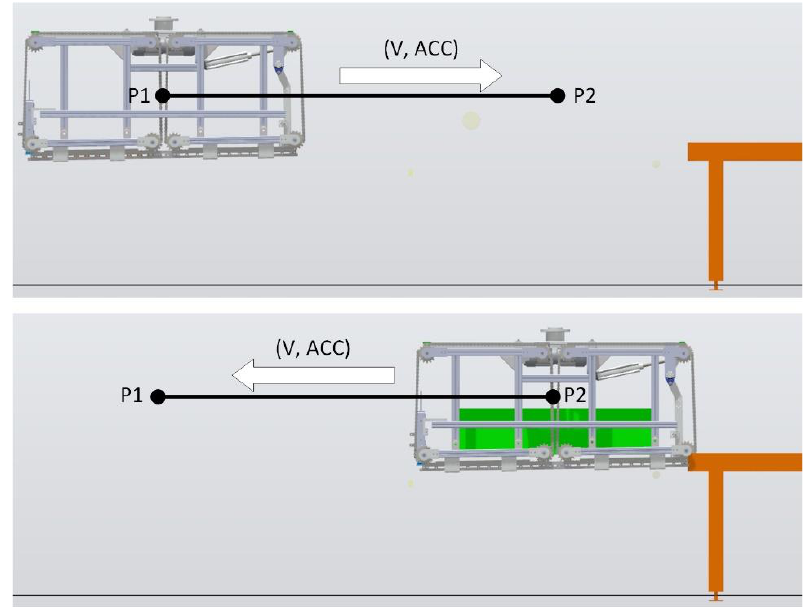
Figure 11. Robot approach to process point. P1 — start point, P2 — process point, V — linear speed of the robot, ACC — acceleration coefficient.